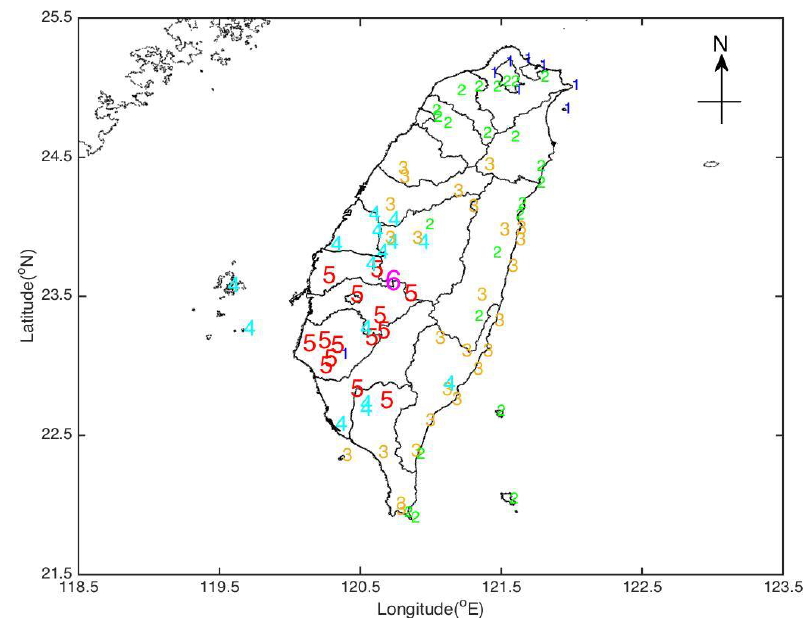
Figure 6. The intensity scale distribution reported by the CWB for the earthquake occurring on 27 March 2013.